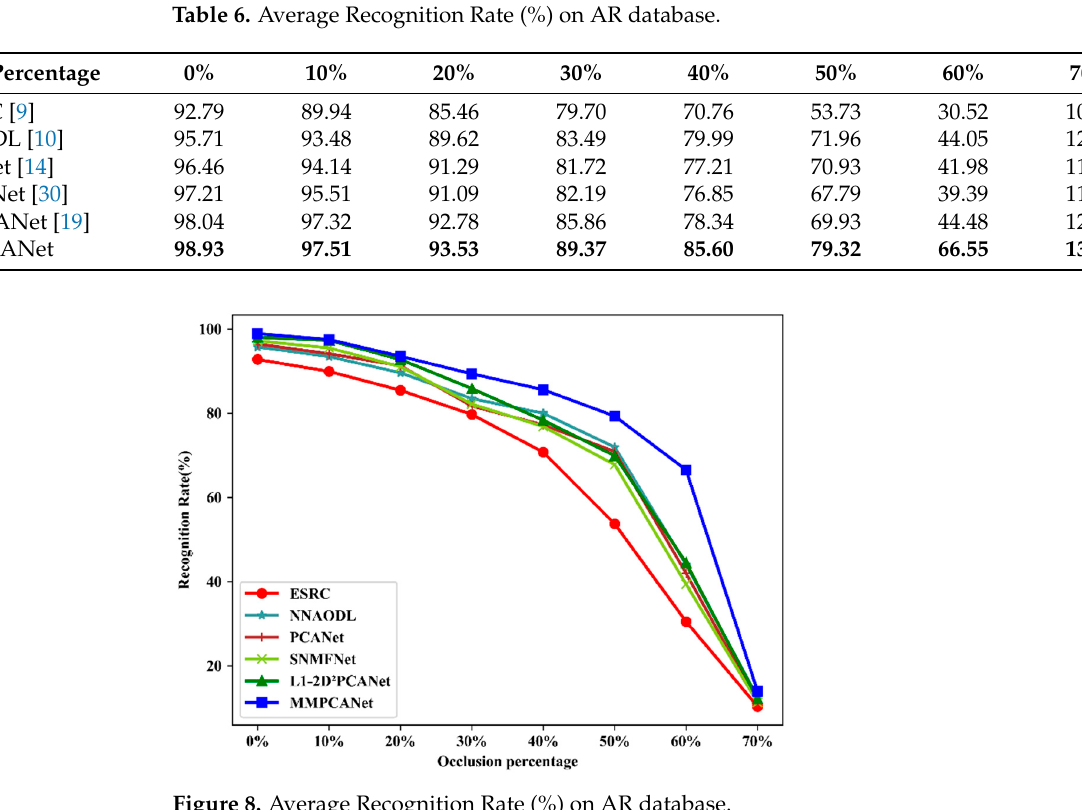
Figure 8. Average Recognition Rate (%) on AR database.